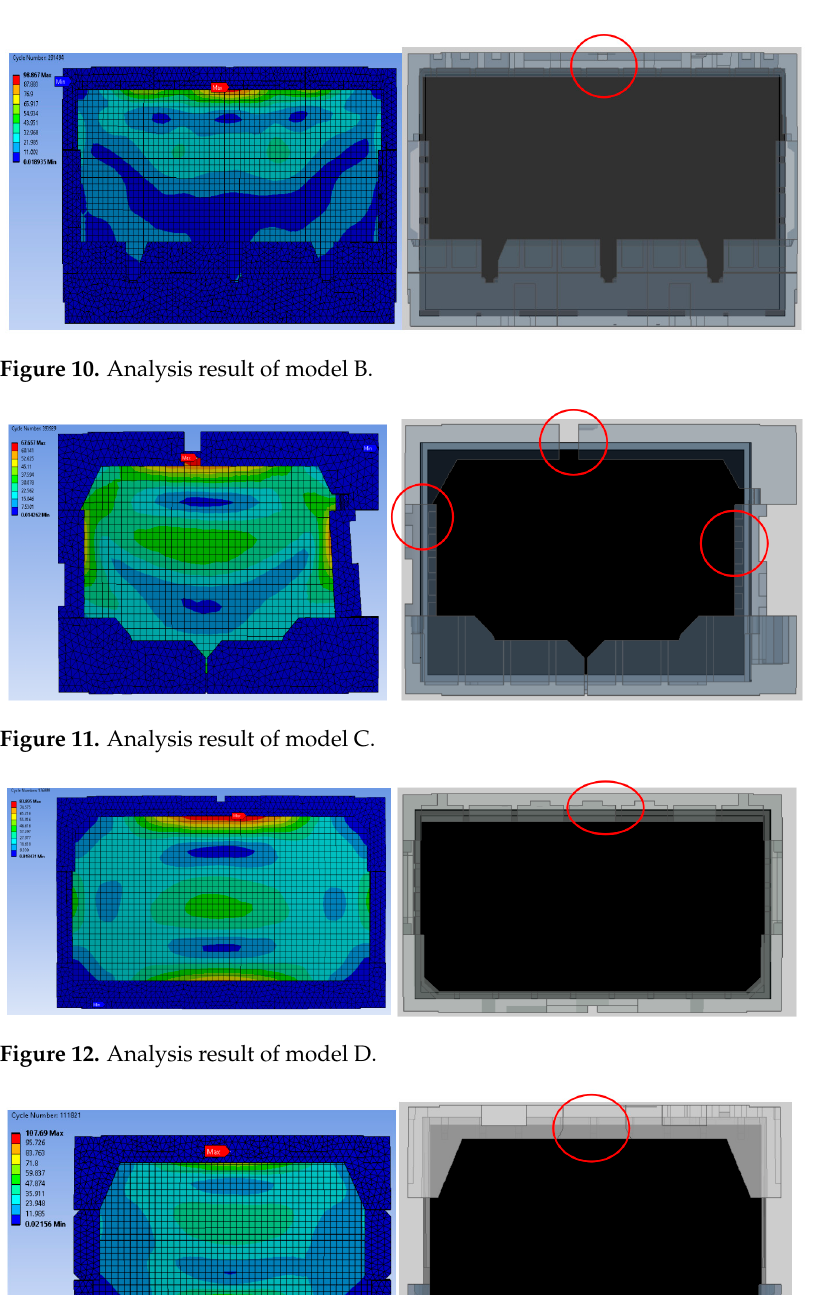
Figure 9. Analysis result of model A.